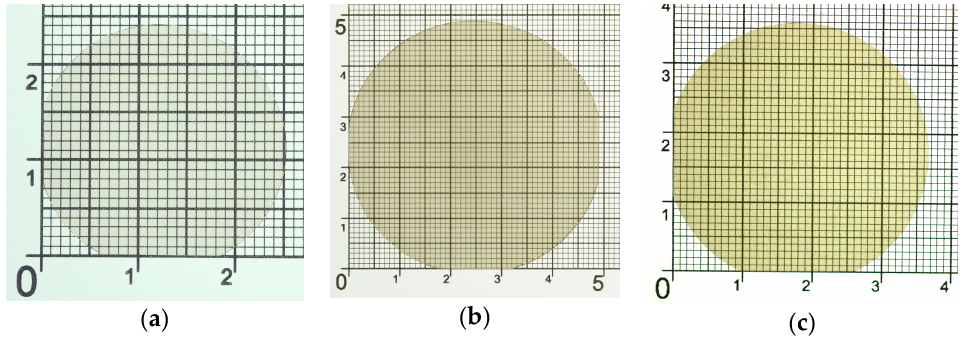
Figure 1. GaN substrates obtained by the ammonothermal method: ( a ) 1” low n-type highly transparent, ( b ) 2” n-type (10 19 cm − 3 ), and ( c ) 1.5” SI-type.